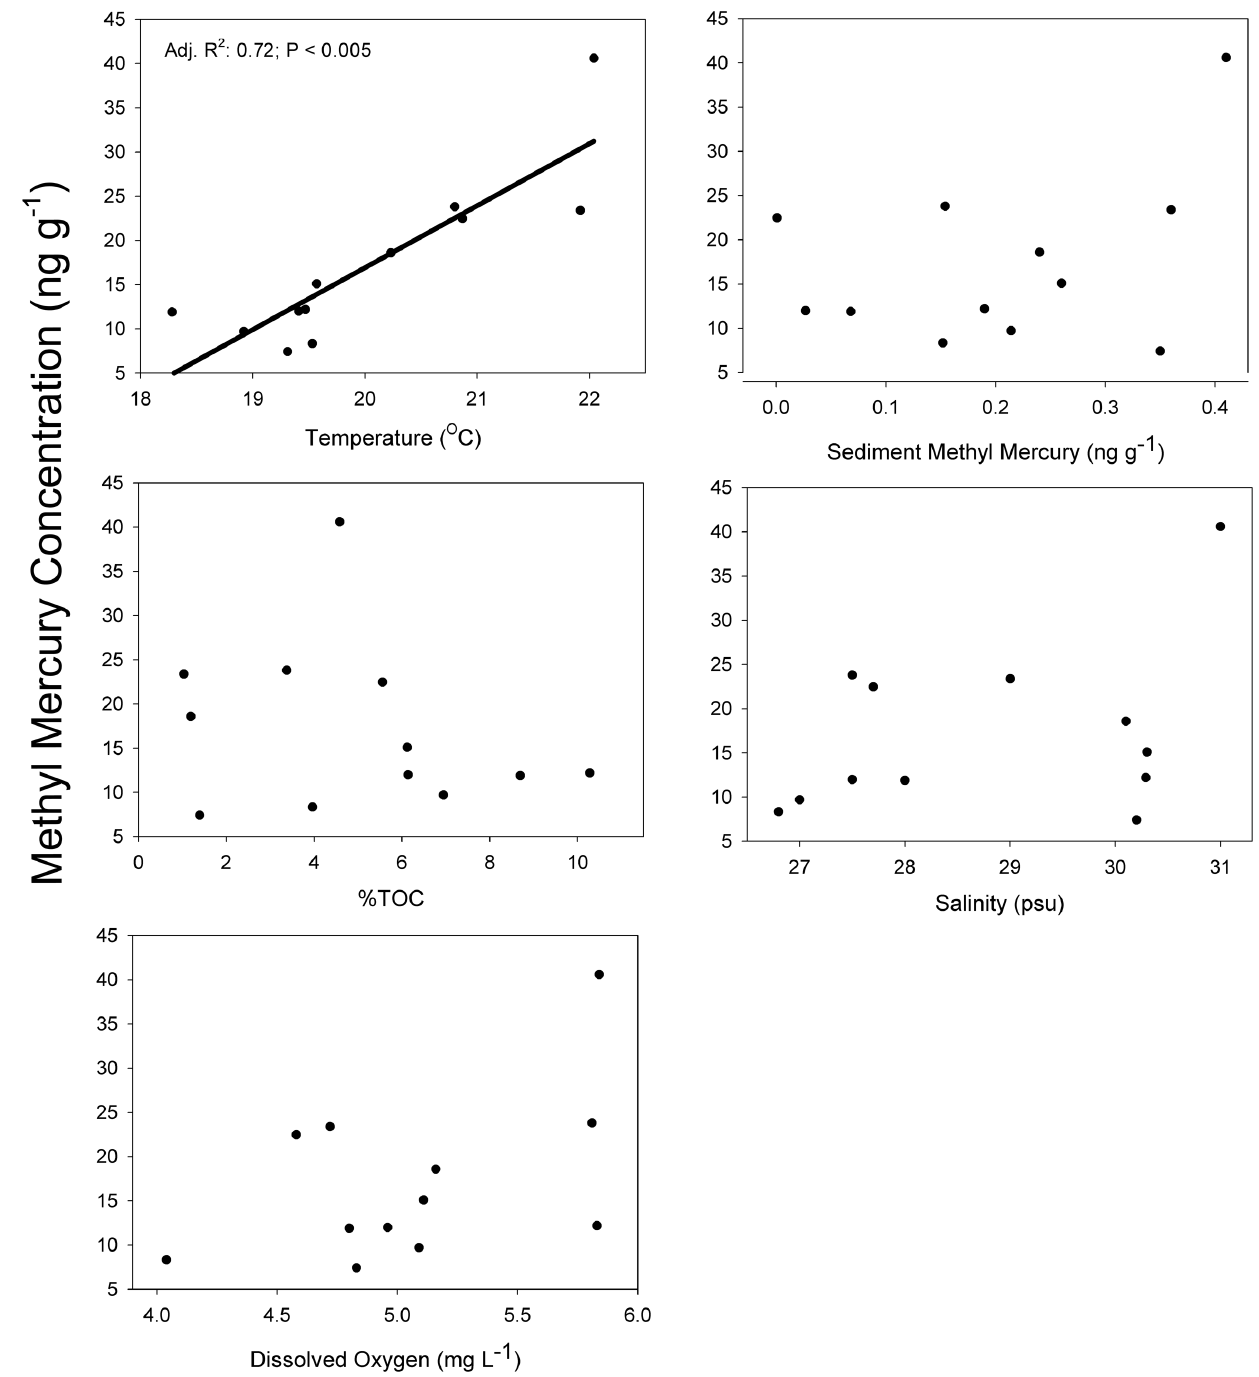
Figure 2. Mean tissue MeHg concentrations (ng g 2 1 dry fish tissue) in enclosed pools plotted against average individual environmental parameters collected from salt marsh pools. There are no significant relationships between fish MeHg concentrations and salinity, dissolved oxygen, %TOC, or sediment MeHg. In contrast to other environmental variables, temperature shows a significant positive regression with tissue MeHg